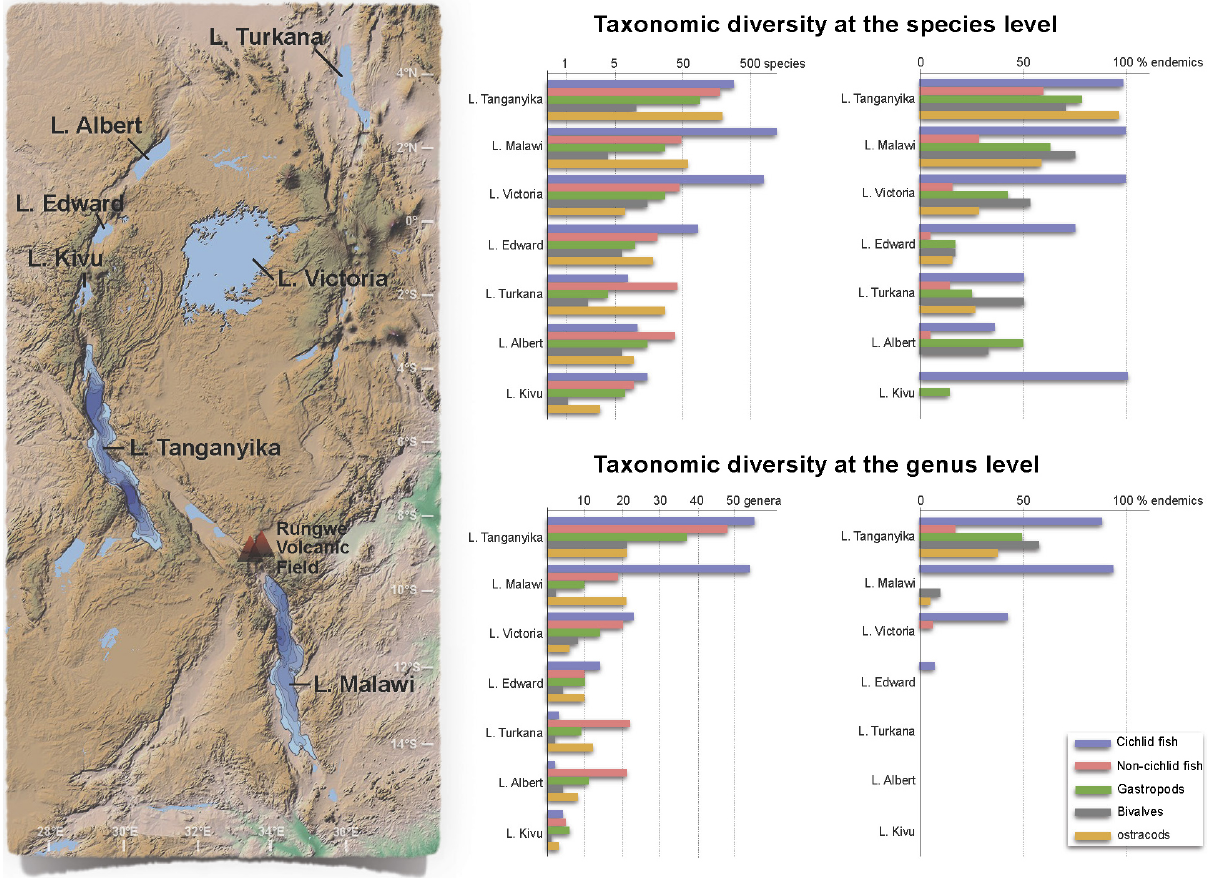
Figure 1. Taxonomic diversity of the African Great Lakes. The figure illustrates the unique characteristics of Lake Tanganyika’s endemic diversity, where the age and persistence of the lacustrine environment is reflected in the large numbers and percentages of endemic genera among many groups of organisms in comparison to other